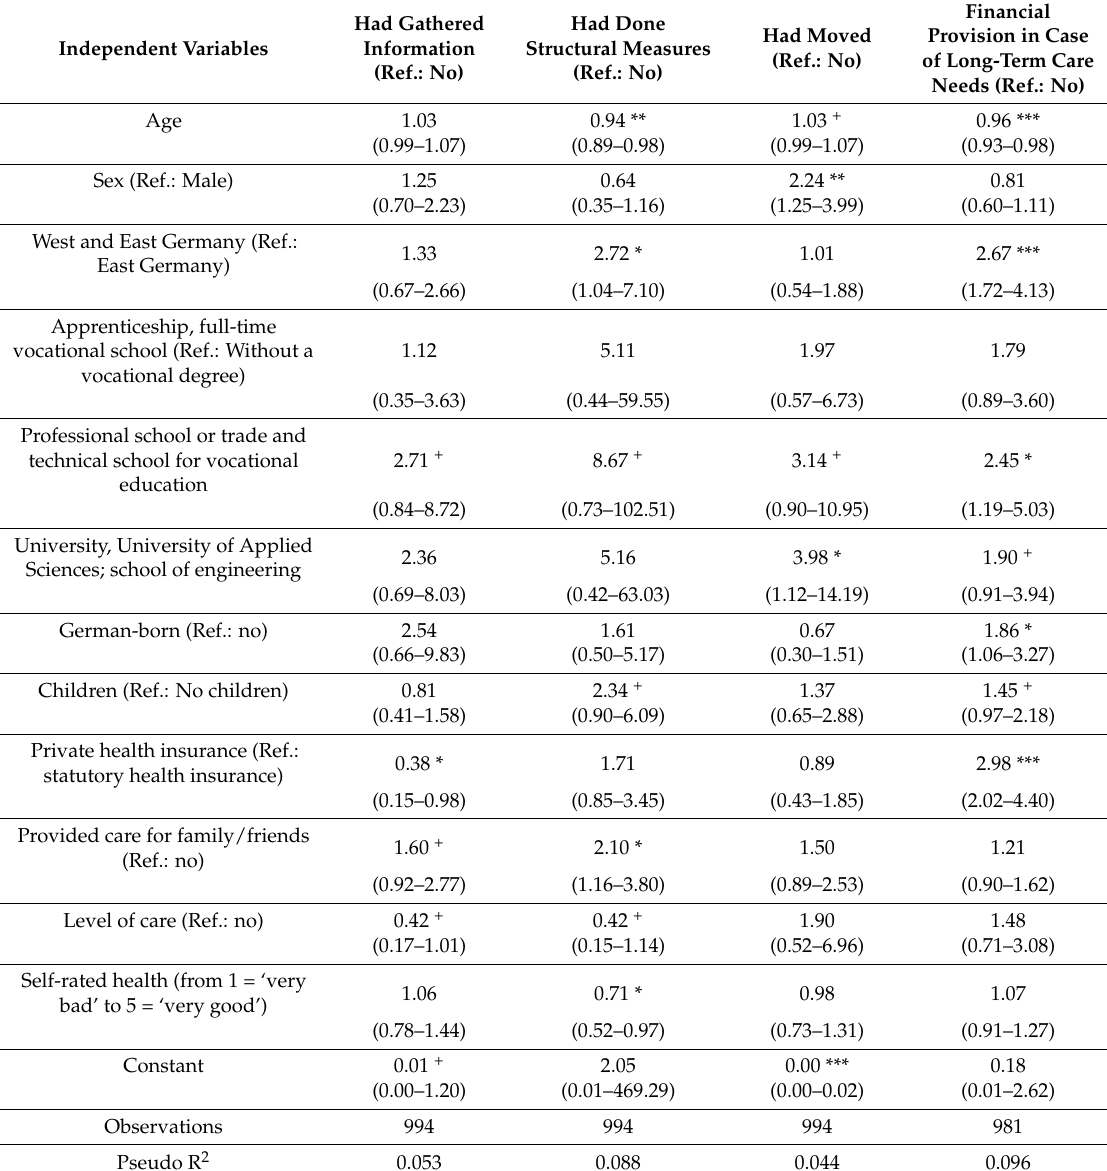
Table 2. Correlates of specific actions and financial provision in case of long-term care needs. Results of multiple logistic regressions (for each outcome measure: 0 = no; 1 =